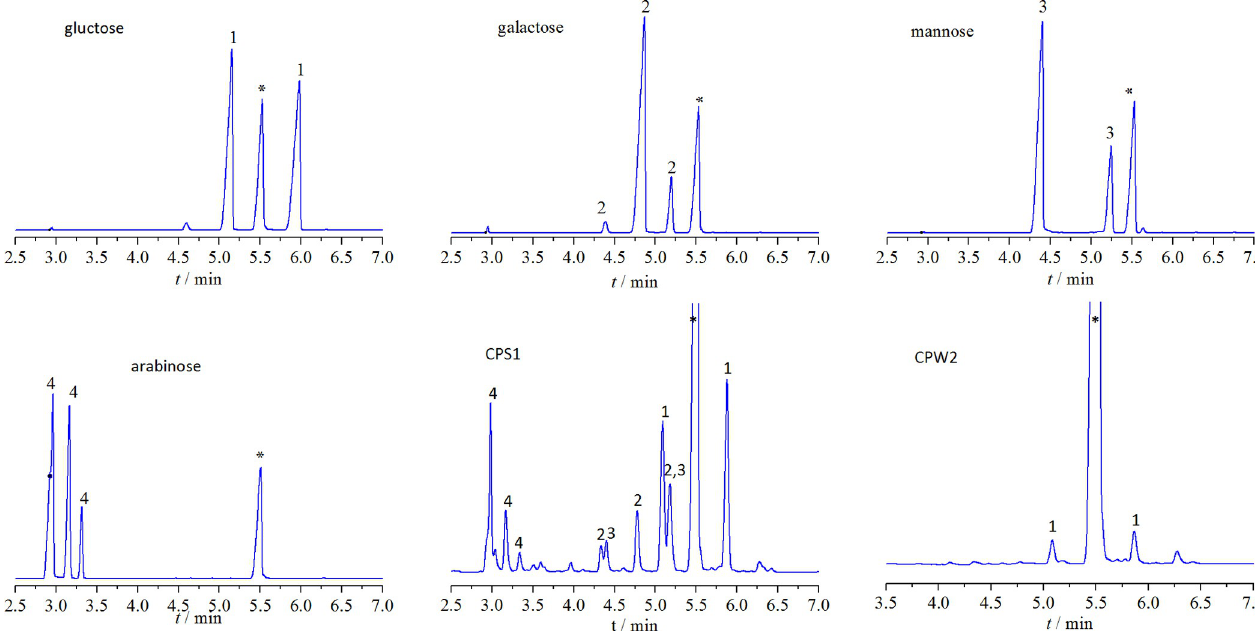
Fig 3. GC chromatograms of derivatives from monosaccharide standards, CPS1, and CPW2. * represents mannitol, 1–4 refer to derivatives from glucose, galactose, mannose, and arabinose.